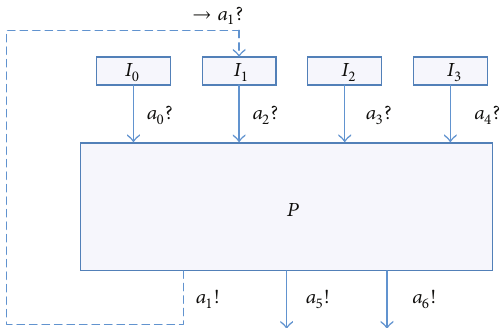
Figure 6: The structure of the aircraft braking